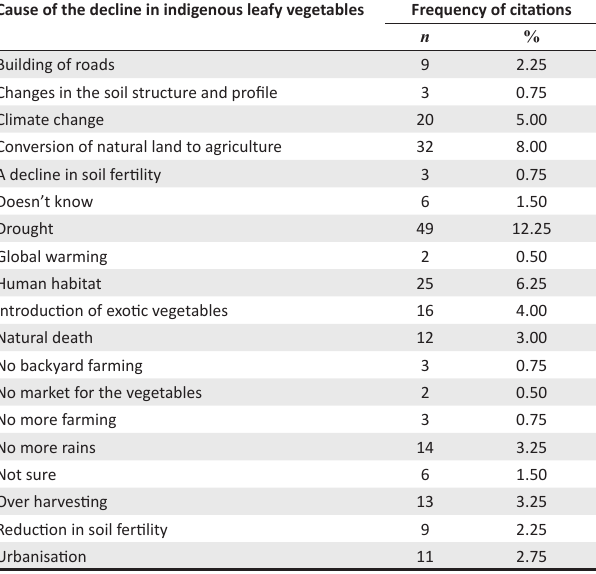
TABLE 3: Causes of the decline in indigenous leafy vegetables.